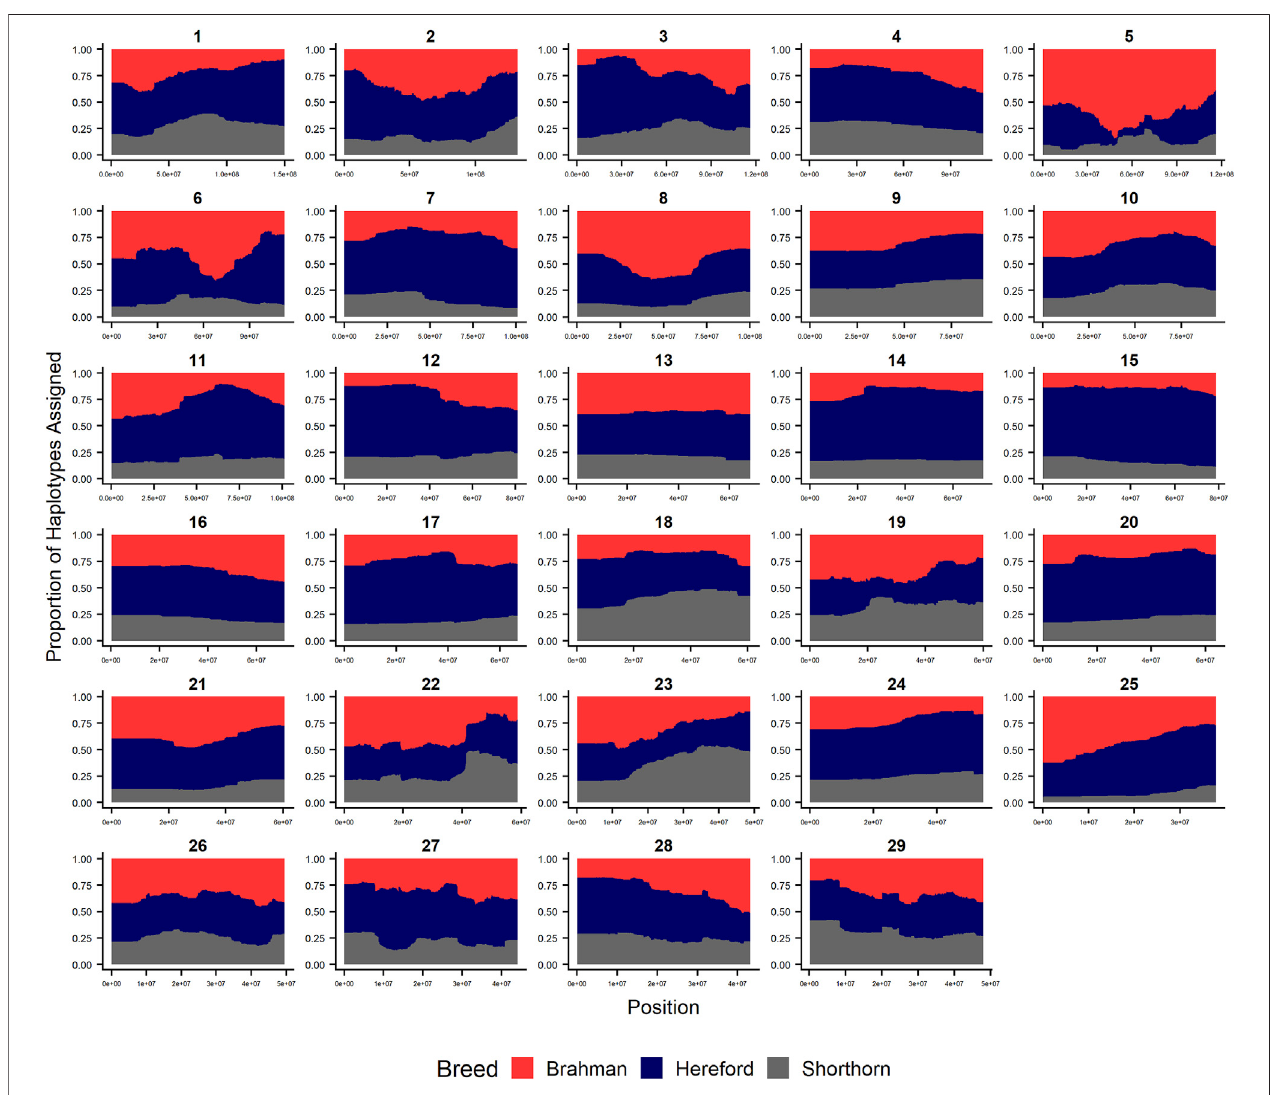
FIGURE3| RFMixmostlikelyassignmentbychromosomefortheANCESTRALreference panelforeach25SNPwindowforBeefmaster.Brahman(red),Hereford (navy) and Shorthorn (gray). Beefmaster is expected to be ½ Brahman, ¼ Hereford and ¼ Shorthorn.